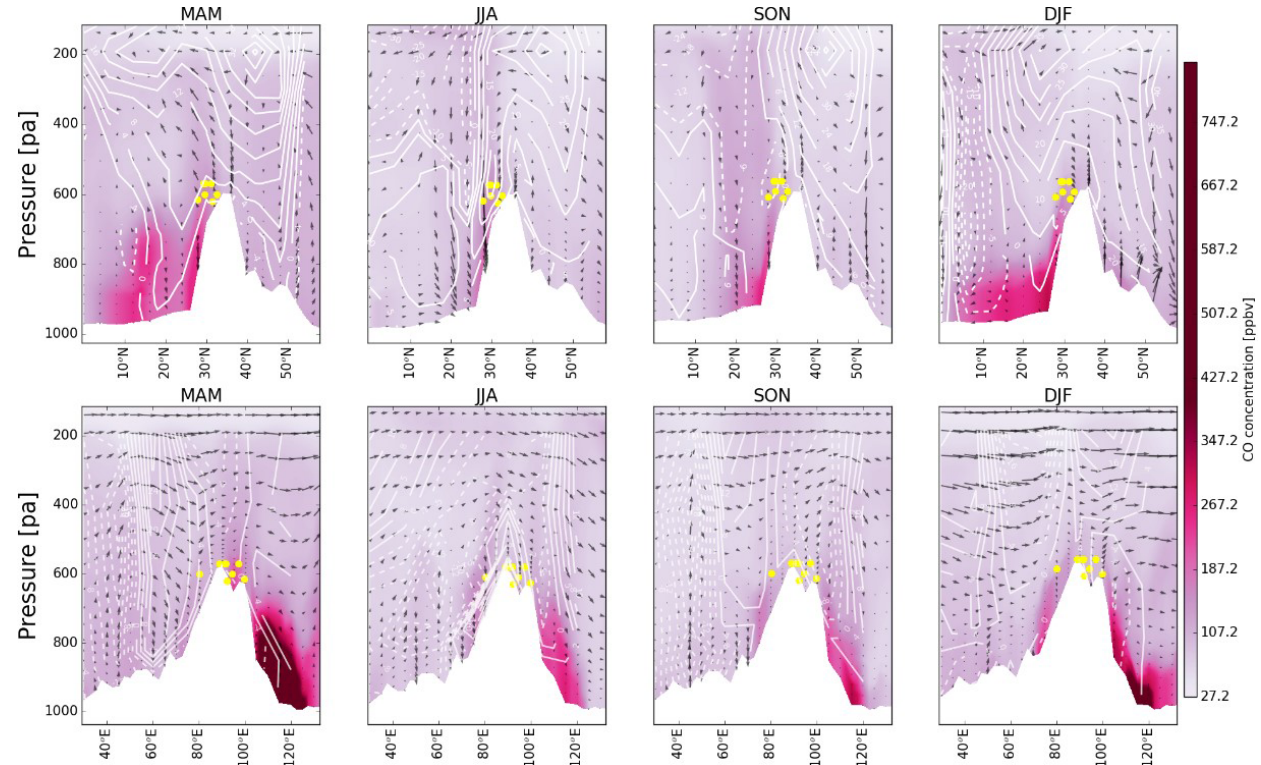
Figure 13. The first row shows the latitude–height distributions of CO VMR averaged over 80–100 ◦ E in the tagged CO simulations in different seasons (corresponding to different columns). The white contours at intervals of 6ms − 1 represent the westerly (solid) and easterly (dashed) mean meridional winds; the white area represents topography and the arrows represent the wind vectors (vertical velocity in units of 10 − 4 hPas − 1 and zonal wind in ms − 1 ); the studied regions are marked with yellow dots. The second row is similar to the first row except that the quantities are on the longitude–height perspective averaged over 28–33 ◦ N. Here the white contours represent the southerly (solid) and northerly (dashed) mean zonal winds, and the horizontal component of the wind vectors is meridional wind (ms − 1 ). Meteorological fields are from the GDAS-1